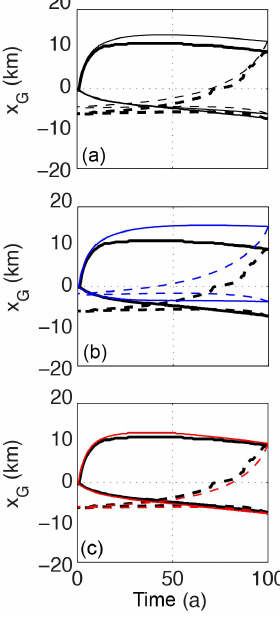
Figure 8. GL evolution on both the symmetry axis (upper curves) and free-slip boundary (lower curves) for the P75S (solid curves) and P75R (dashed curves) comparisons between FELIX-S (bold- black curves) and Elmer/Ice DI ( a , thin black curves), LG ( b , thin blue curves), and FF ( c , thin red curves). The number of elements along the y direction is 80 ( (cid:49)y = 625m). Note that GL positions are plotted relative to their equilibrium positions in the Stnd exper- iment.